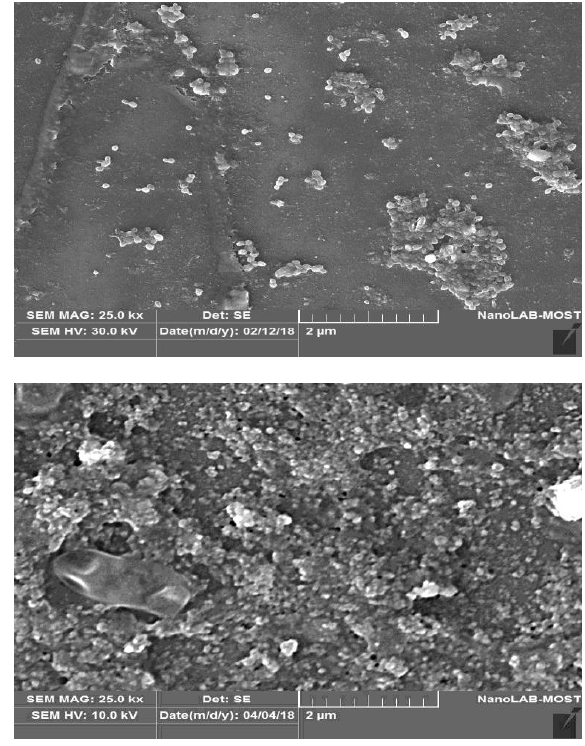
Figure, 4; Morphological and size characterization of Selenium Nanoparticles. The result of the analysis of the SEM micrographic image represented in( Fig. 4